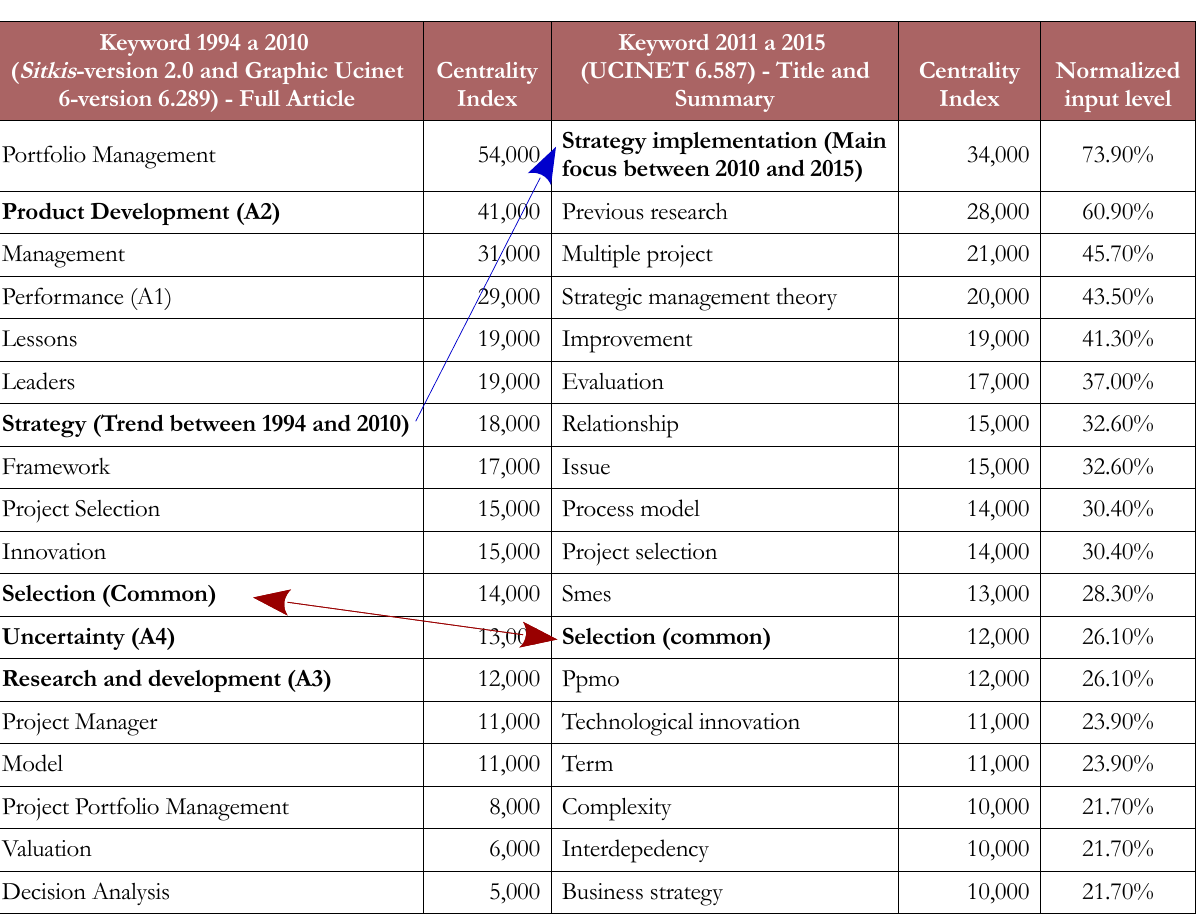
Table 3. Comparison of the Centrality Index between articles from 1994 to 2000 and 2011 to 2015 in the keyword network According to Modica, Braun and Rabechini Jr. (2010), portfolio management is presented as a complex